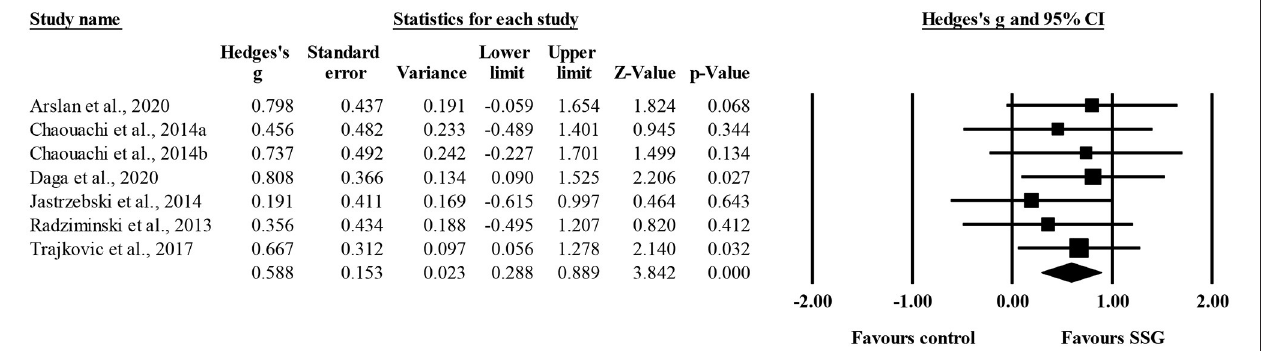
FIGURE 2 | Forest plot of changes in technical execution, in youth athletes from team sports participating in SSG-based programs (intervention) compared to controls. Values shown are effect sizes (Hedges’s g) with 95% confidence intervals (CI). The size of the plotted squares reflects the statistical weight of the study. The black diamond reflects the overall